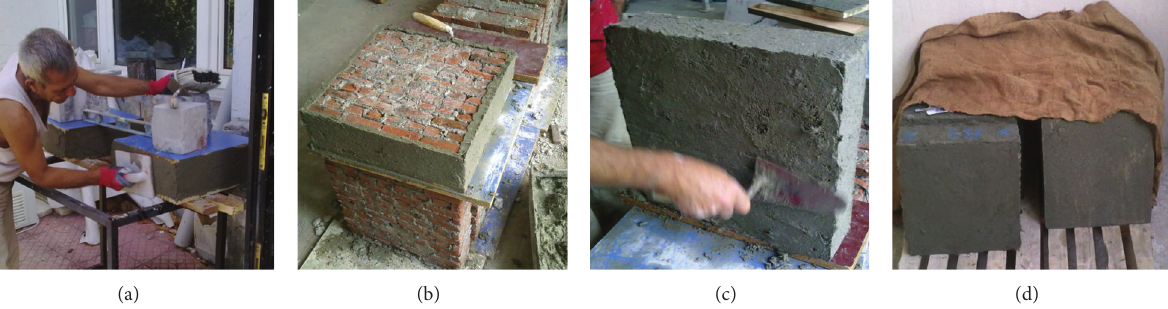
Figure 7: The masonry wall with reinforced plaster mortars.